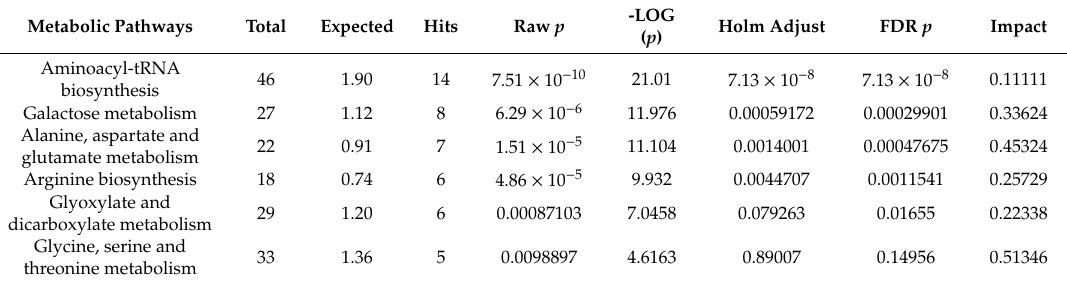
Table 2. Results of the pathway analysis of leaf and root samples of the low-N sensitive (HM-4) and low-N tolerant (PEHM-2) maize genotypes grown under the conditions of low-N, su ffi cient-N and restorations of N supply (3rd, 6th and 10th